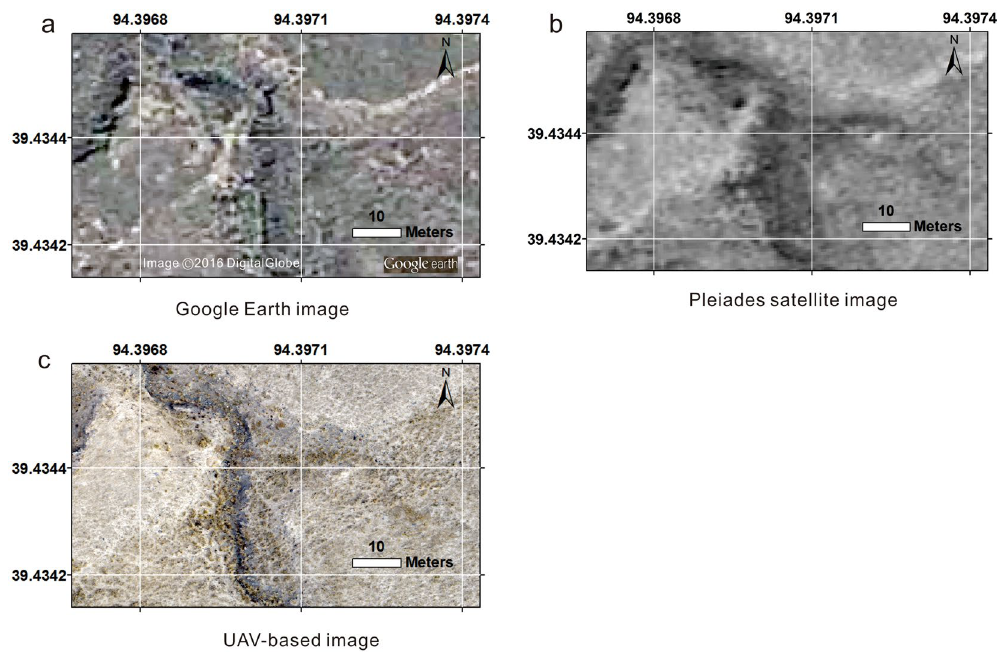
Figure 2. Comparison among ( a ) a Google (DigitalGlobe), and ( b ) a Pleiades satellite image (0.7 m resolution), and ( c ) the UAV image obtained by this study (0.016 m